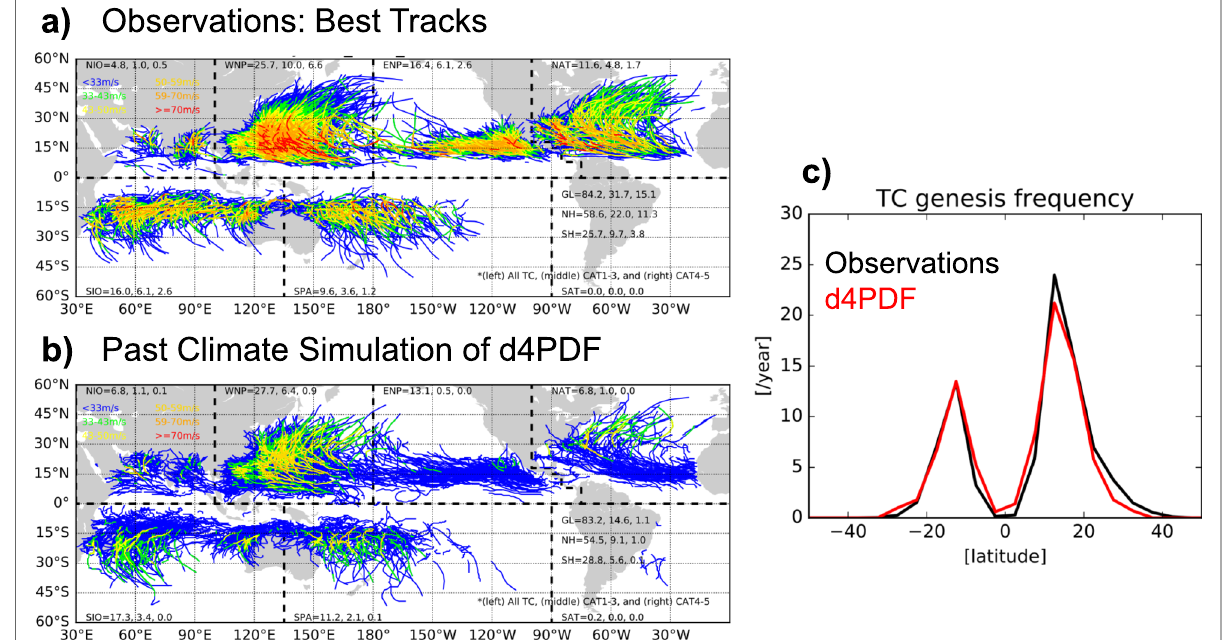
Fig. 6 a Observed (Knapp et al. 2010) and b simulated tropical cyclone trajectories. The simulation of d4PDF-G is of one member under the past climate condition. The trajectories are colored depending on wind speed. c Genesis frequencies of a and b as a function of latitude (Yoshida et al.